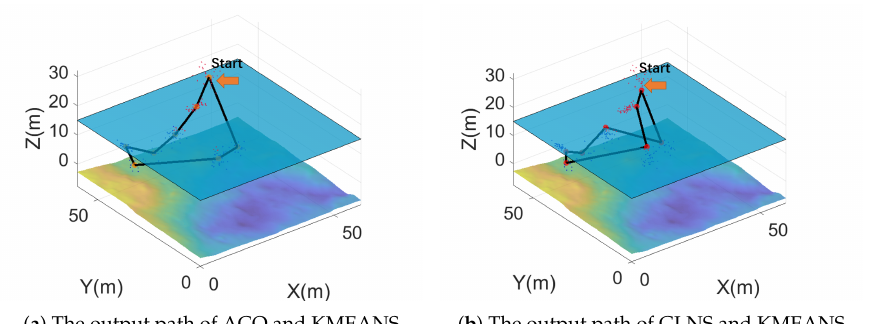
Figure 15. A comparison of the paths generated by ACO and GLNS. In this scenario, 189 spots were divided into eight groups. The HAUV began at one spot and went back to the starting spot when the mission was finished. With the conditions in the table above, the total length of the path found by ACO was 719.0682 within 1.037 s, whereas GLNS’s path was 528.578, found in 3.0140 s.